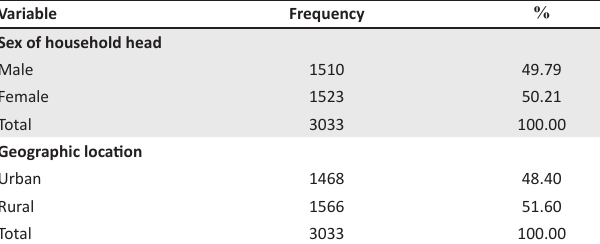
TABLE 1: Demographic characteristics of Eastern Cape sample from the General Household Survey 2016.